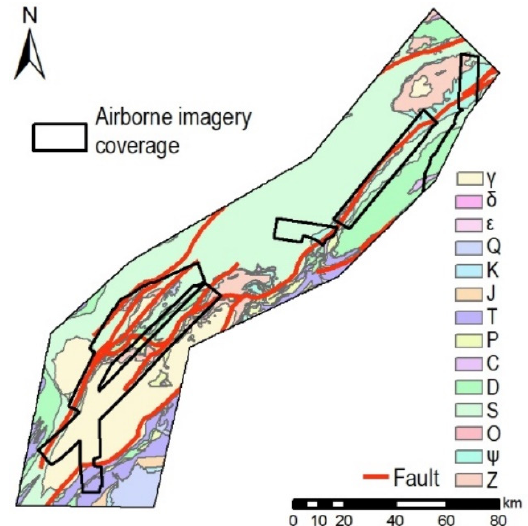
Figure 5. Lithology and fault factors of post-earthquake landslides. Table 2. The description of lithology in the study area.